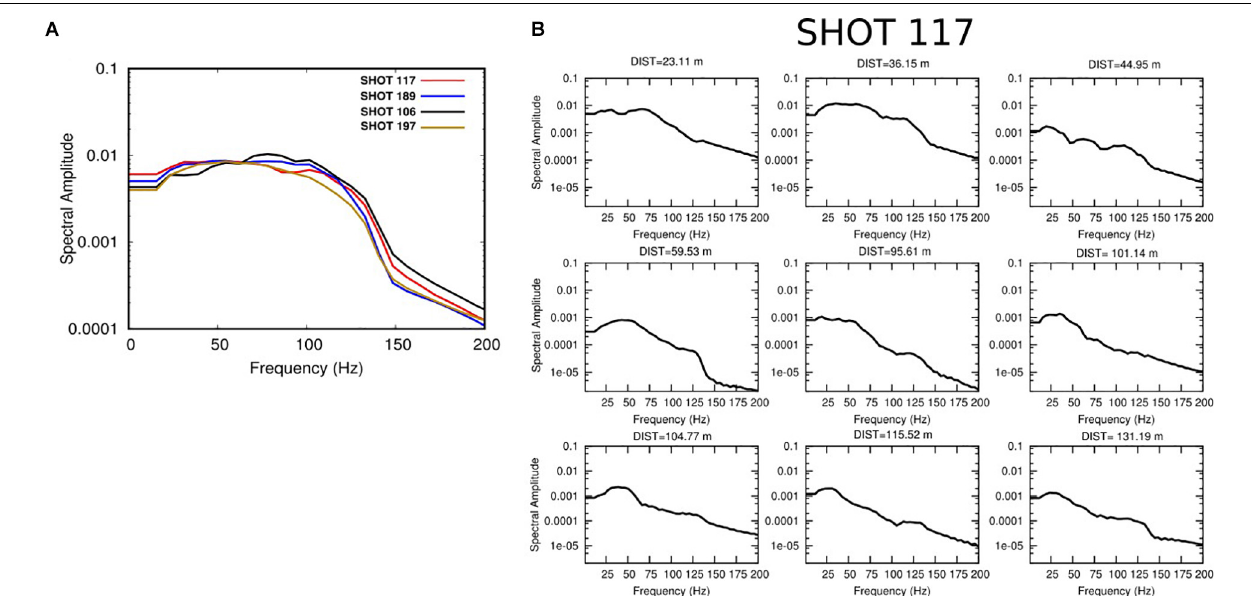
FIGURE 3 | (A) Displacement spectra computed as the average of spectra recorded at the four closest receivers to each of the four selected shots. Each curve represents the average displacement spectrum for different source, following the color legend in figure. Spectra were computed in a 0.128 s long time window. The position of shots on the field is represented in Figure 2 . (B) Spectra computed at increasing distances from the shot 117. The effect of anelastic absorption on high frequencies is clear, in particular if we compare these to the “source”